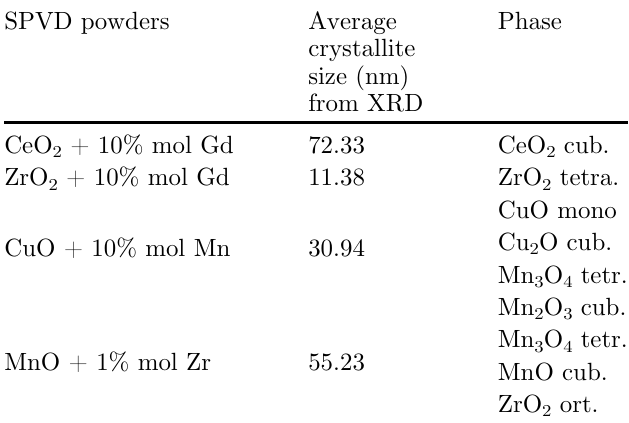
Table 3. XRD results.